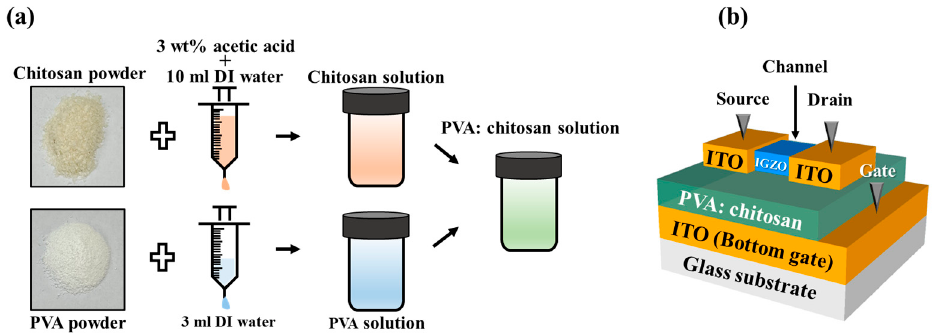
Figure 1. ( a ) Fabrication details of PVA:CS blended solution. ( b ) Schematic diagram of PVA:CS bi- opolymer blended EDL-based synaptic transistor on glass substrate. biopolymer blended EDL-based synaptic transistor on glass